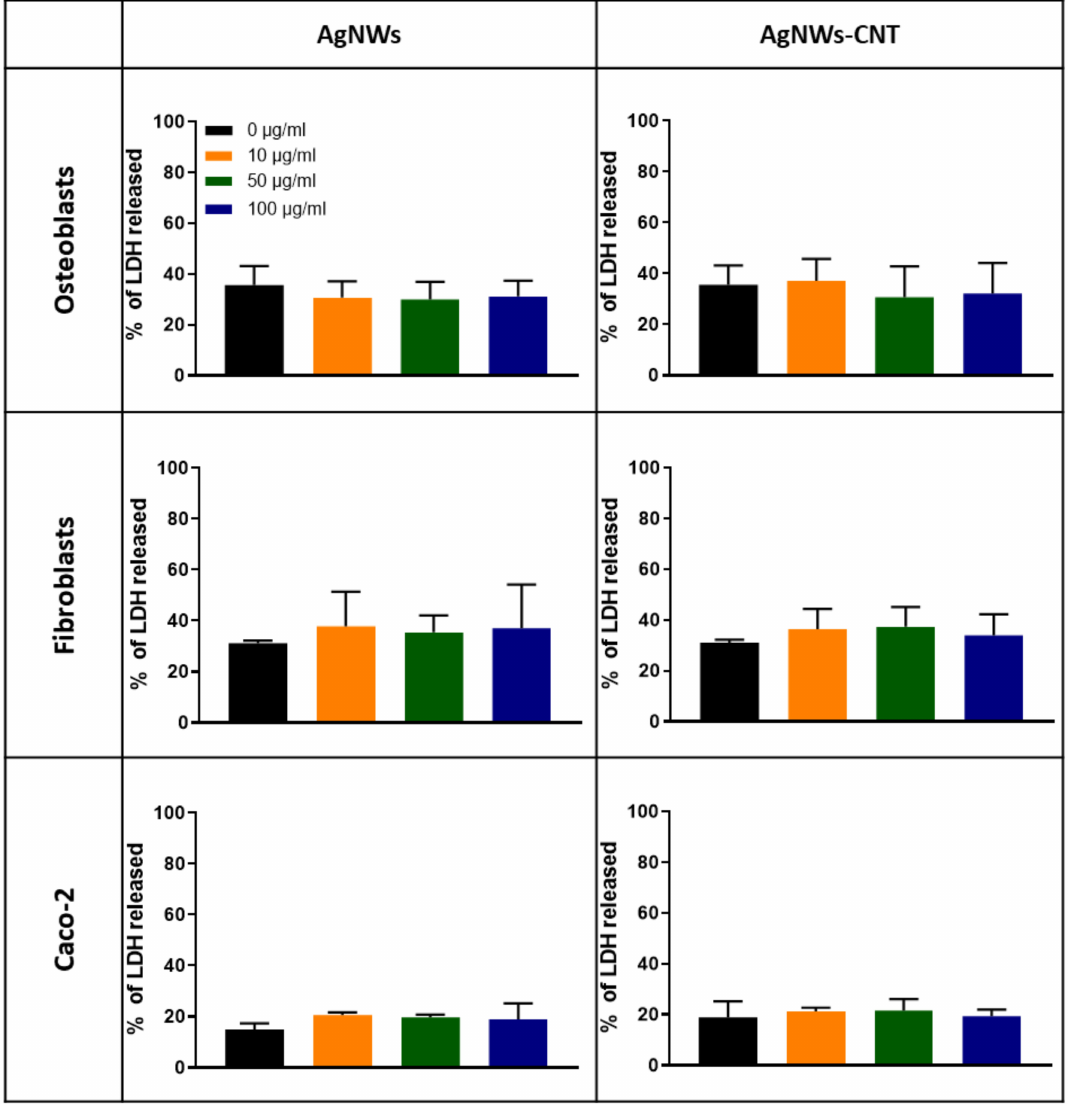
Figure 8. Percentage LDH release from osteoblasts, fibroblasts and Caco-2 after 24 h of exposure to di ff erent concentrations of AgNWs or AgNWs-CNTs. The one-way ANOVA calculated among the di ff erent concentrations of each test did not show statistical di ff erences ( p > 0.05). Data are reported as the mean ± SD ( n =